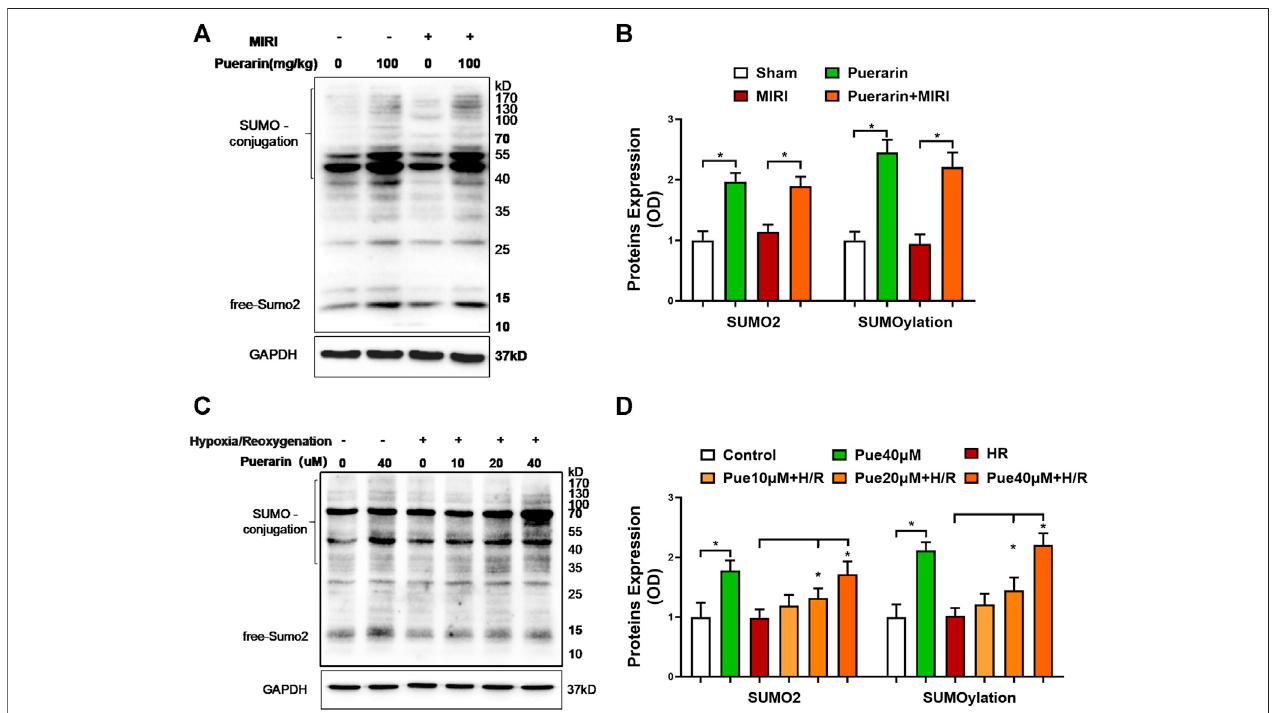
FIGURE3| EffectsofpuerarinonSUMO2expressionandSUMOylationinmouseMI-RImodelandhypoxiareoxygenation-challengedH9c2cells. (A) Invivo effects of puerarin on SUMO2 expression and SUMOylation. After ischemia for 45 min and reperfusion for 24 h, heart tissues were collected and analyzed by Western blotting withantibodiesagainstSUMO2,whereasGAPDHwasanalyzedasacontrol. (B) Quanti fi cationofSUMO2expressionandSUMOylationlevels.TheblotsinpanelAwere quanti fi ed by a densitometric method. The results were shown as mean ± SD ( n (cid:2) 6). * p < 0.05. (C) In vitro effects of puerarin on SUMO2 expression and SUMOylation levels. After hypoxia (0.1% O 2 ) for 3 h and reoxygenation for 24 h, H9c2 cells were collected and analyzed by Western blotting with antibodies against SUMO2, whereas GAPDH was analyzed as a control. (D) Quanti fi cation of SUMO2 expression and SUMOylation levels. The blots in panel C were quanti fi ed by a densitometric method. The results were presented as mean ± SD ( n (cid:2) 3). * p <